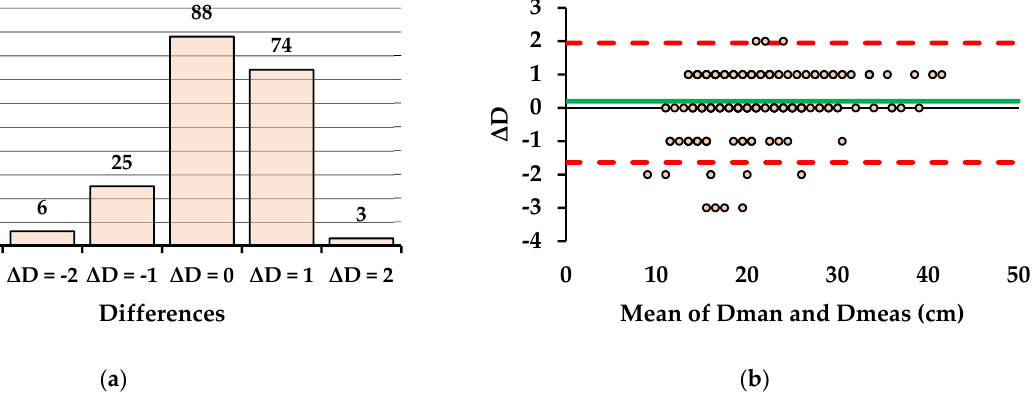
Figure 11. Agreement of diameter measurement methods in E2: ( a ) Absolute frequency of differences ( Δ D) between Dman and Dmeas; ( b ) Bland-Altman plot showing the differences plotted against the mean of paired measurements, the bias (green line), and the lower and upper limits of agreement (red dashed lines).